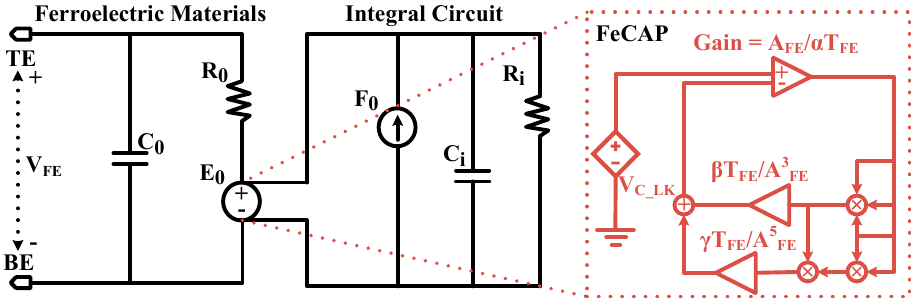
Figure 15. Ferroelectric capacitance model.